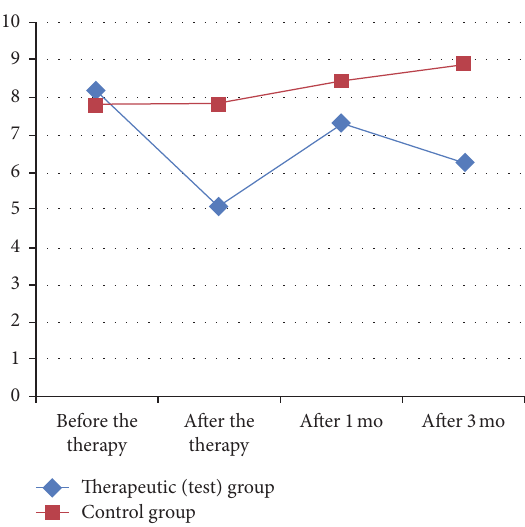
Figure 6: Contact surface area [cm 2 ] dynamic